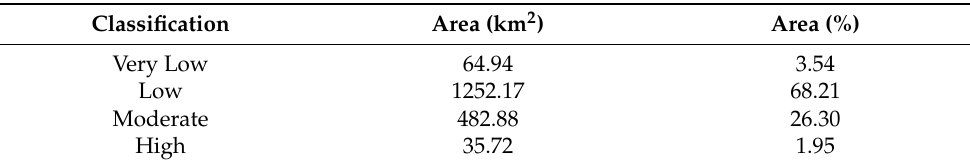
Figure 11. Groundwater Potential Zones Map of the San Luis Potosi Basin. Table 7. Groundwater Potential Zones classification and their area